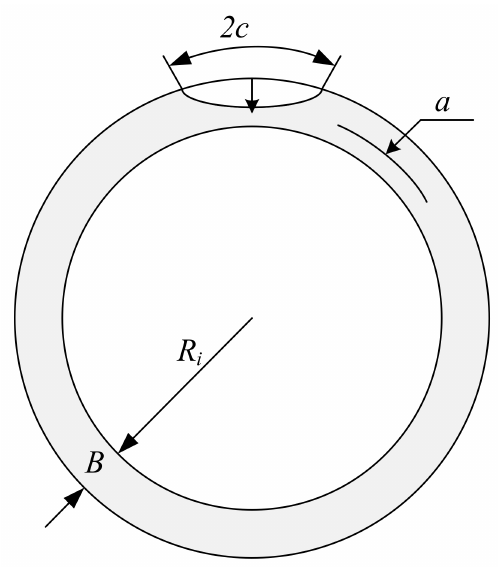
Figure 4. Schematic diagram of cracks at the girth